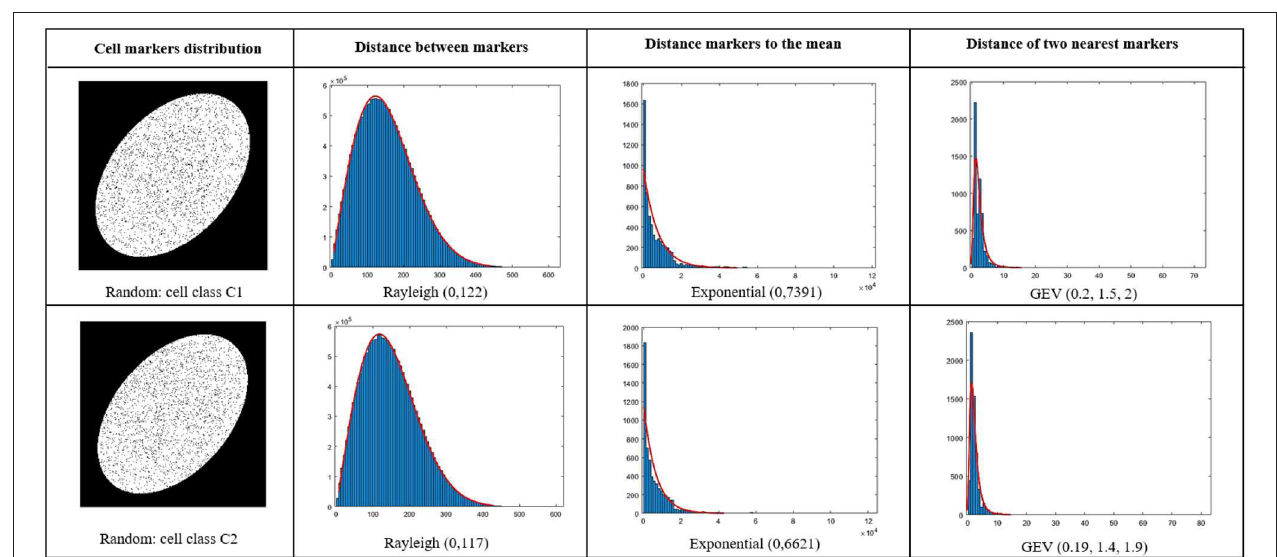
FIGURE 5 | Fit of distances with distributions selected from BIC criterion among a large set of common distributions as in Neath and Cavanaugh (2012). Blue stands for histogram and red for the fit. Upper line for a cell ( C 1 ) and a cell ( C 2 ) on the second line.